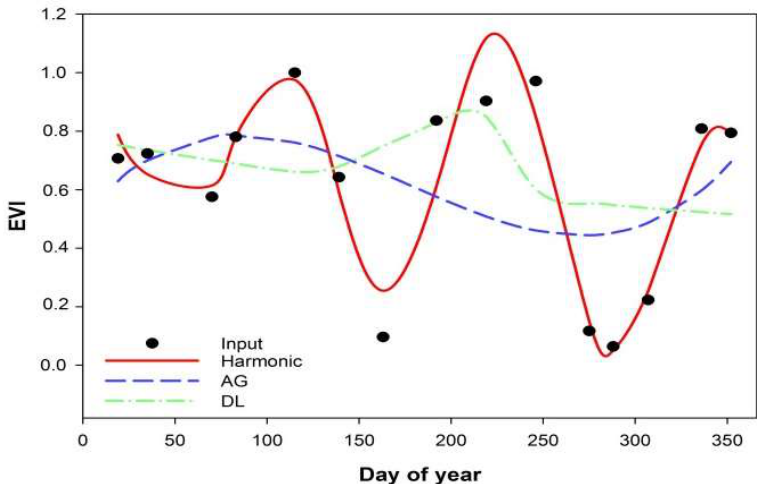
Figure 2. The three models fitted to time-series from homogeneous pixels of cropland derived from the Landsat Operational Land Imager (OLI) time-series image in 2015. The three models are the local asymmetric Gaussian function (AG), the double logistic (DL), and the harmonic model respectively.